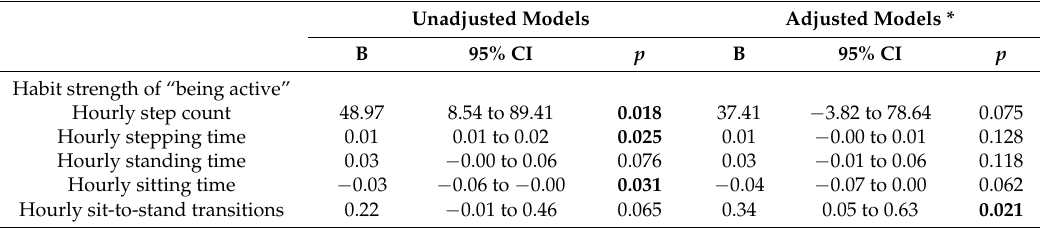
Table 2. Median habit scores for “being active” as predictors of objective physical activity measures. Unadjusted Models